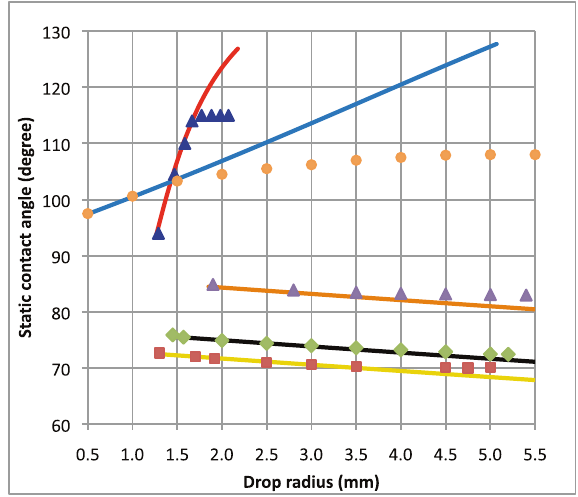
Fig. 7 Comparison of proposed model with published experi- mental data. Legend: blue triangles — Herzberg and Marian 2 (Table 1), orange solid line — present model ( S ¼ (cid:1) 0 : 96 and l σ = 0.25mm); orange dots — Ponter and Yekta-Fard 3 (Figure 4), blue solid line — present model ( S ¼ (cid:1) 0 : 77 and l σ = 0.035mm); purple triangles — Li and Neumann 6 (Figure 3, lower plot), orange solid line — present model ( S ¼ 0 : 26 and l σ = − 0.015mm); green diamonds — Li and Neumann 6 (Figure 3, middle plot), black solid line — present model ( S ¼ 0 : 42 and l σ = − 0.015mm); red squares — Li and Neumann 6 (Figure 3, top plot), yellow solid line — present model ( S ¼ 0 : 47 and l σ = −